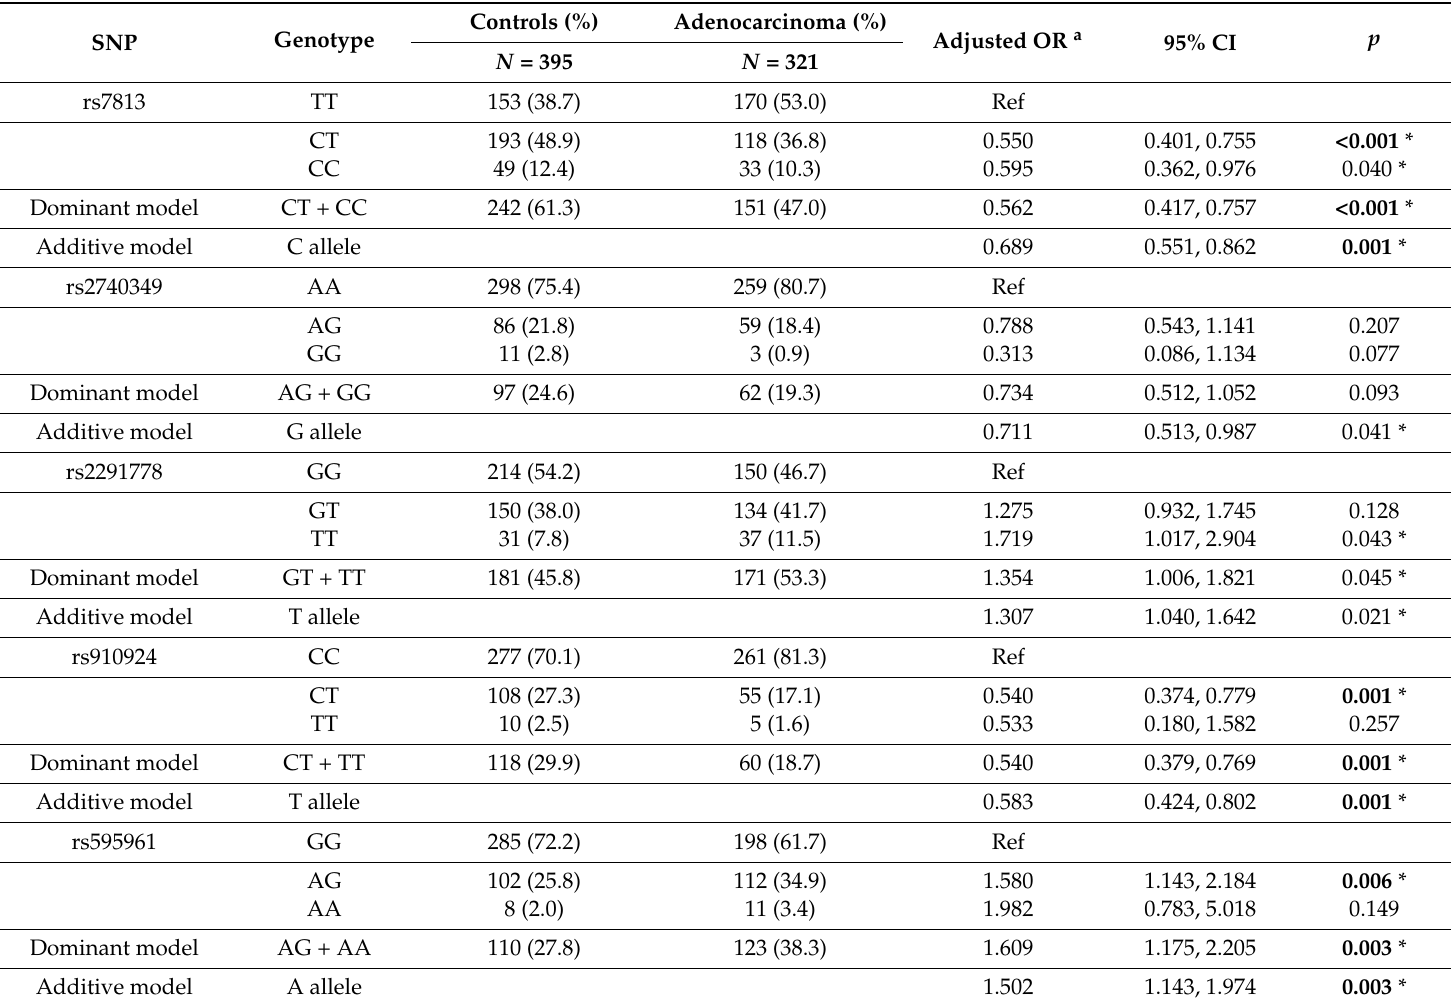
Table 4. Distribution of genotypes and ORs for adenocarcinoma cases and cancer-free